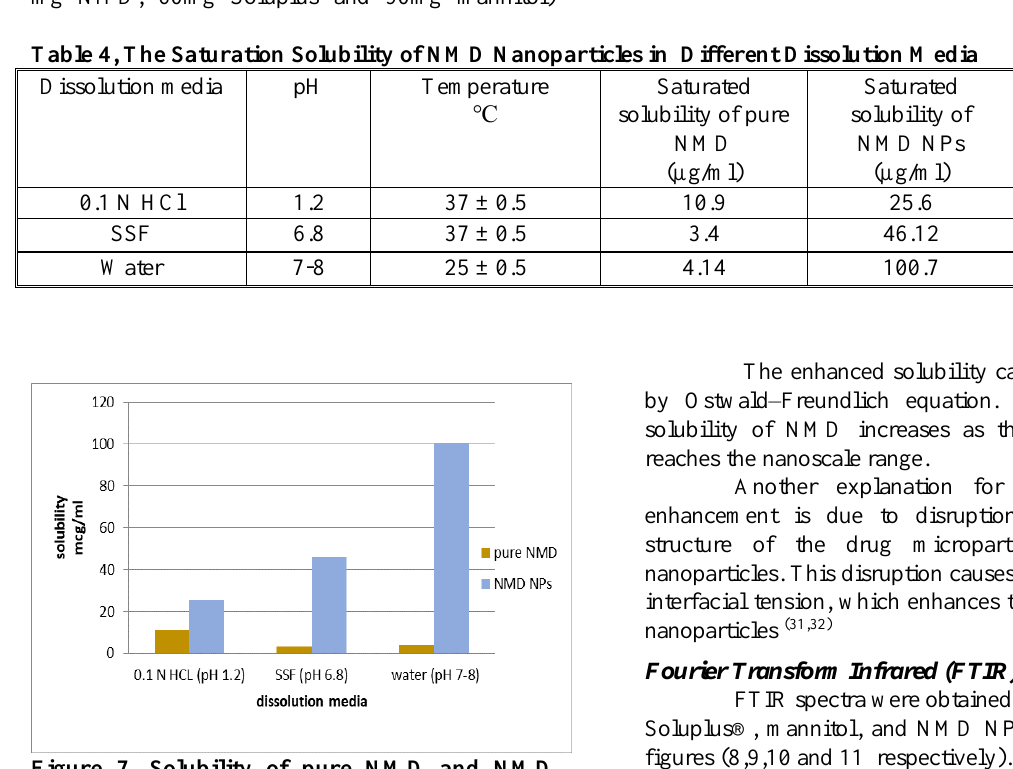
Figure 7. Solubility of pure NMD and NMD nanoparticles in different dissolution